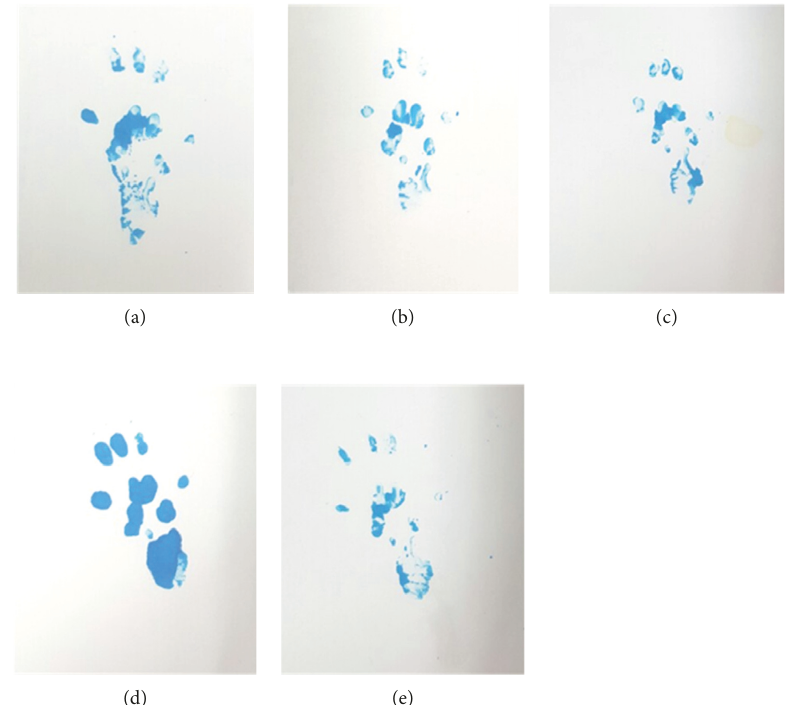
Figure 3: Rat walking track (experimental). (a) Group 1: surgical incision without nerve injury. (b) Group 2: nerve injury with normal saline injection. (c–e) Group 3: nerve injury with 0.5, 6, and 20 μ g · kg − 1 DXM injection (groups 3A, 3B, and 3C,